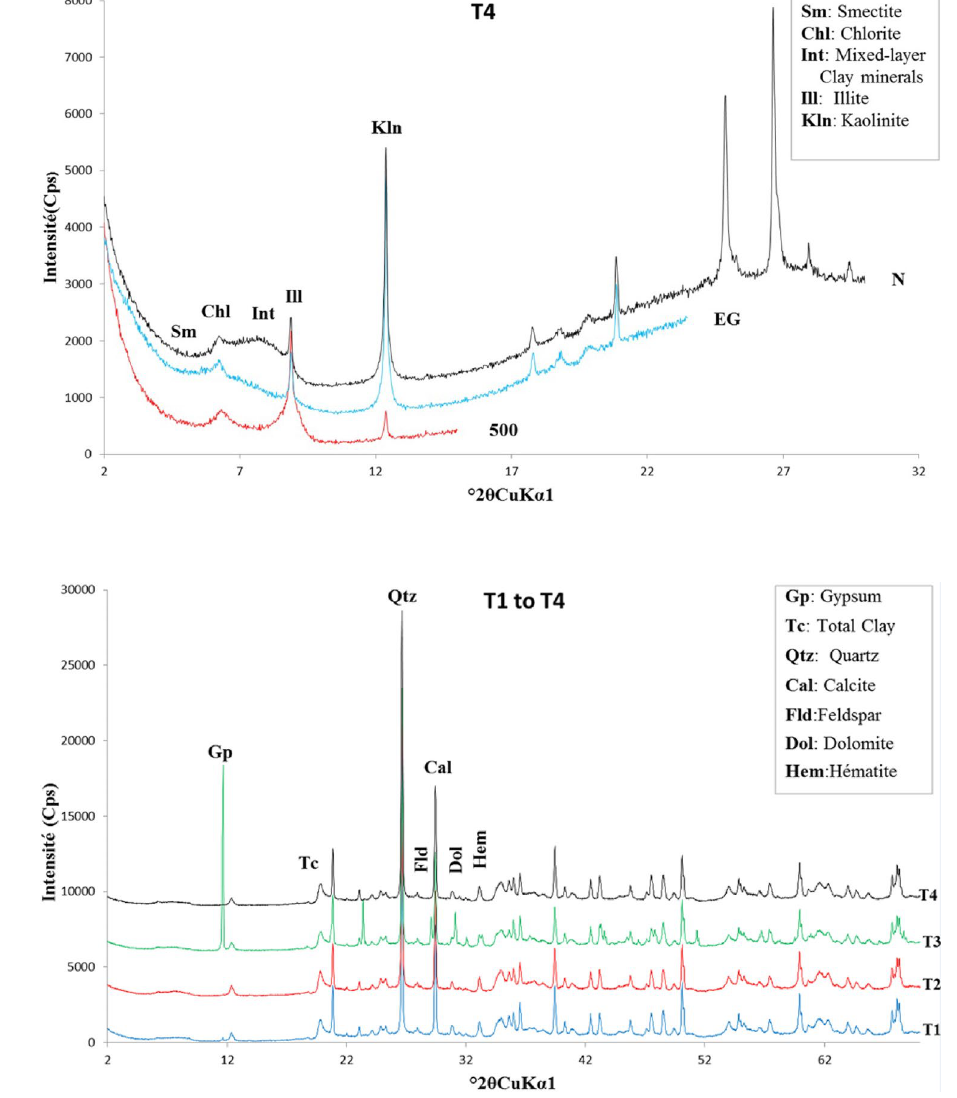
Fig.7 X-ray diffraction patterns (N, EG, 500) for oriented prepa- rations in < 2 µm clay fractions ( Sample: T4 )